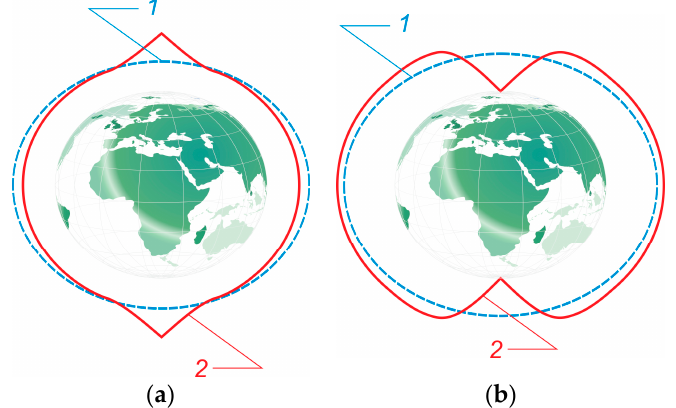
Figure 3. Isobaric surfaces in the atmosphere geostrophic model: 1—undisturbed; 2—disturbed. ( a ) the local maxima at the poles when the overheat at the equator is positive; and ( b ) the local minima at the poles when the overheat at the equator is negative.